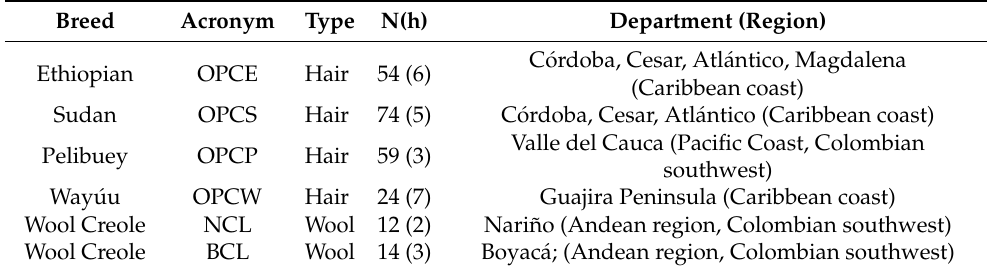
Table 1. List of Colombian Creole sheep breeds, typologies, and geographical positions.